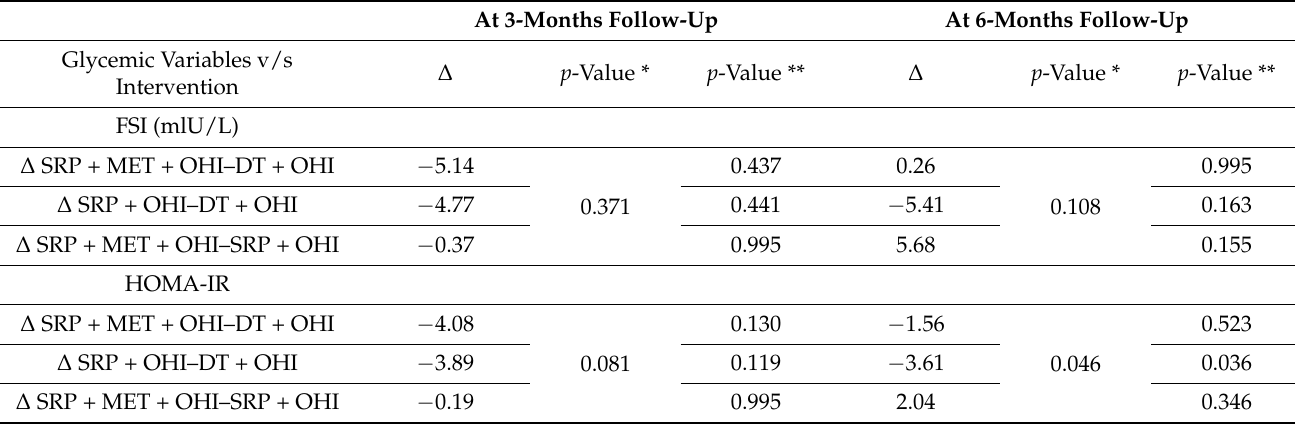
Table 3. Short-term (3-month) and long-term (6-month) effects of SRP with MET and SRP without MET interventions on HOMA-IR.